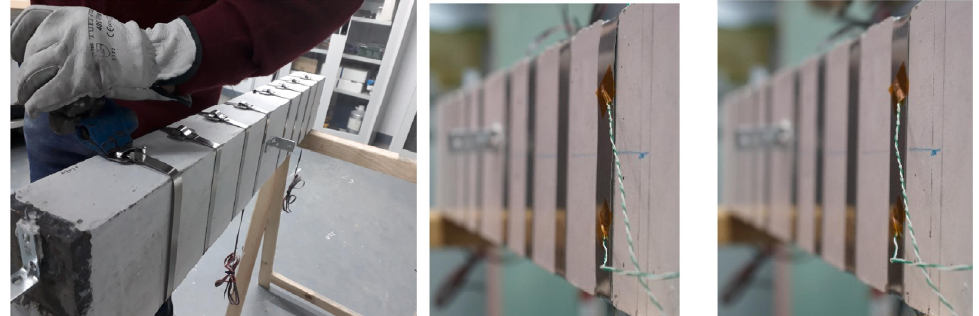
Figure 19. Shear strengthen of the concrete beam with Fe-SMA strips [15].